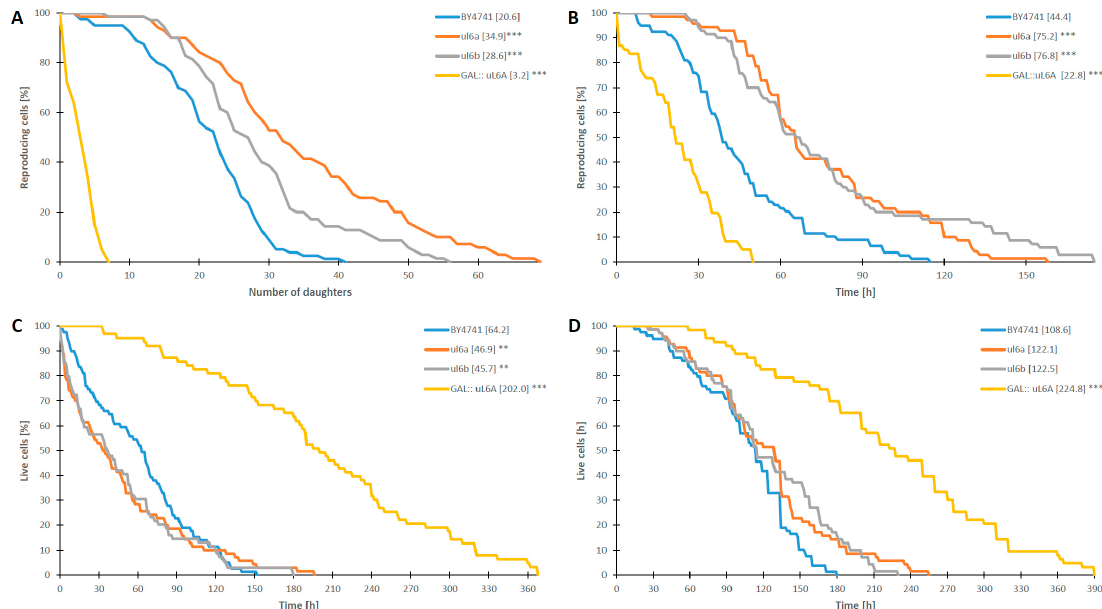
Figure 6. Comparison of the budding lifespan ( A ), reproductive lifespan ( B ), post-reproductive lifespan ( C ), and total lifespan ( D ) of the haploid wild type yeast strain BY4741, isogenic single mutants ∆ ul6A , ∆ ul6B , and the GAL::uL6A mutant after cultivation on solid rich YPD media. Statistical significances were assessed using ANOVA and Dunnett’s post hoc test (** p < 0.05, *** p < 0.001). Data represent mean values from two independent experiments. The mean value for total 90 cells from two independent experiments is shown in parentheses.